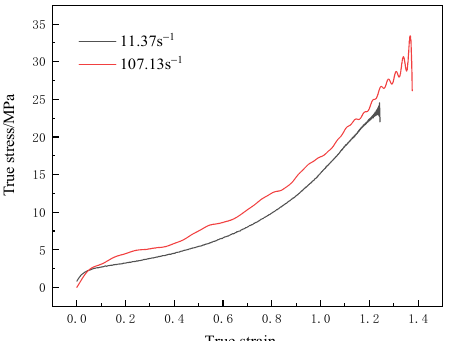
Figure 6. T26 polyurea stress–strain curve at a low strain rate.